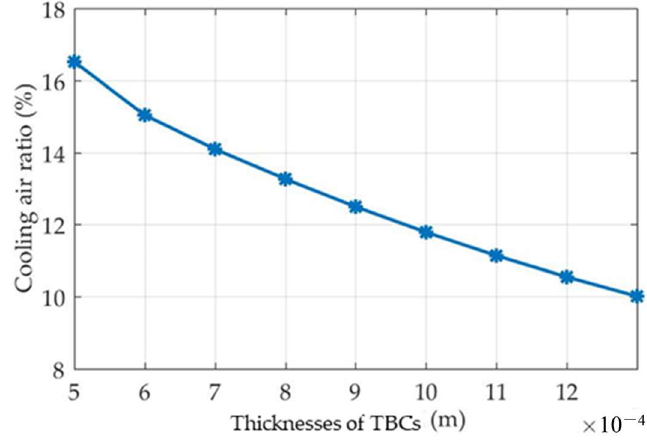
Figure 8. The relationship between the cooling air ratio and TBC thickness.